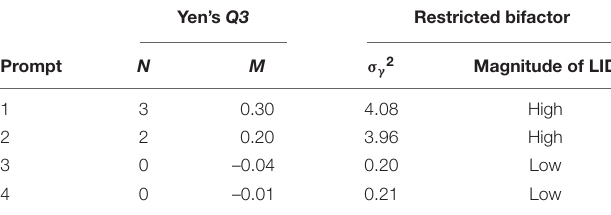
TABLE 3 | Summary of the presence LID for the MDA.